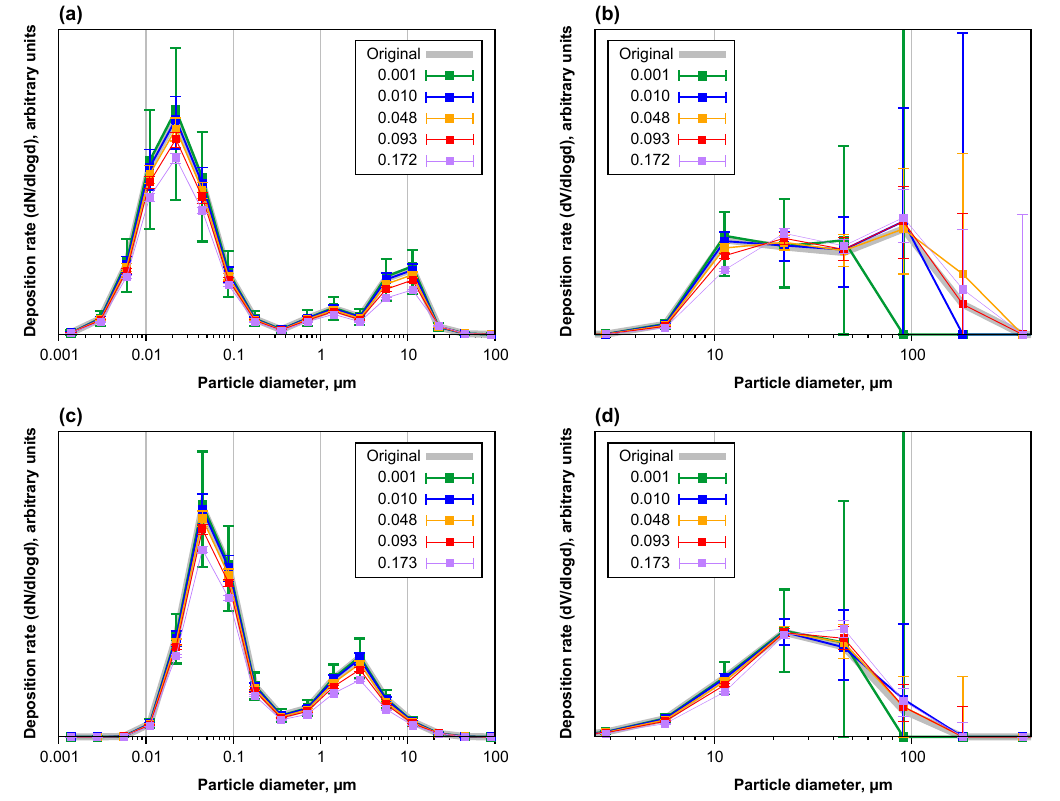
Figure 5. Number (a, c) and volume size distributions (b, d) of deposition rates as function of projected area in diameter, modeled for Cape Verde aerosol as derived from a 5mm × 5mm analysis field. Panels (a) and (b) are based on CV-ground, panels (c) and (d) on CV-air size distributions. The grey curve shows the original size distribution of deposited particles, the colored points with whiskers give median and central 95% quantile of 1000 repetitions (200 for 0.093 and 0.172/0.173) for distributions calculated from samples with different area fractions covered by